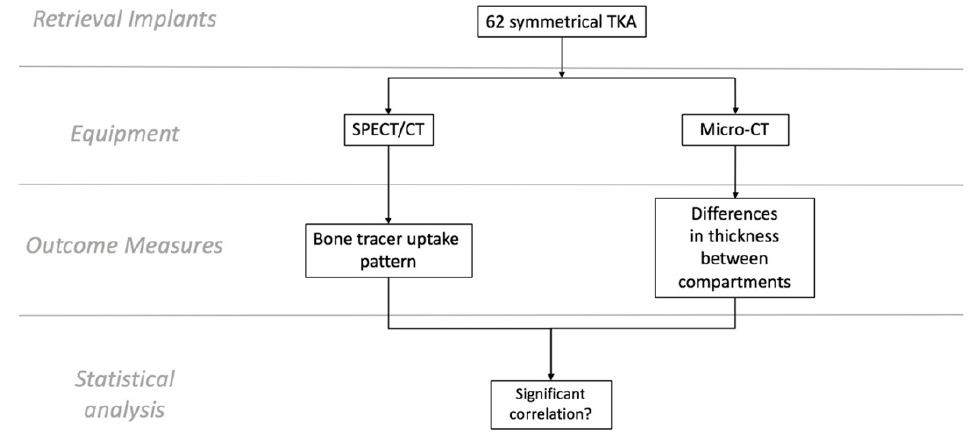
Figure 1. Flowchart showing the study design.